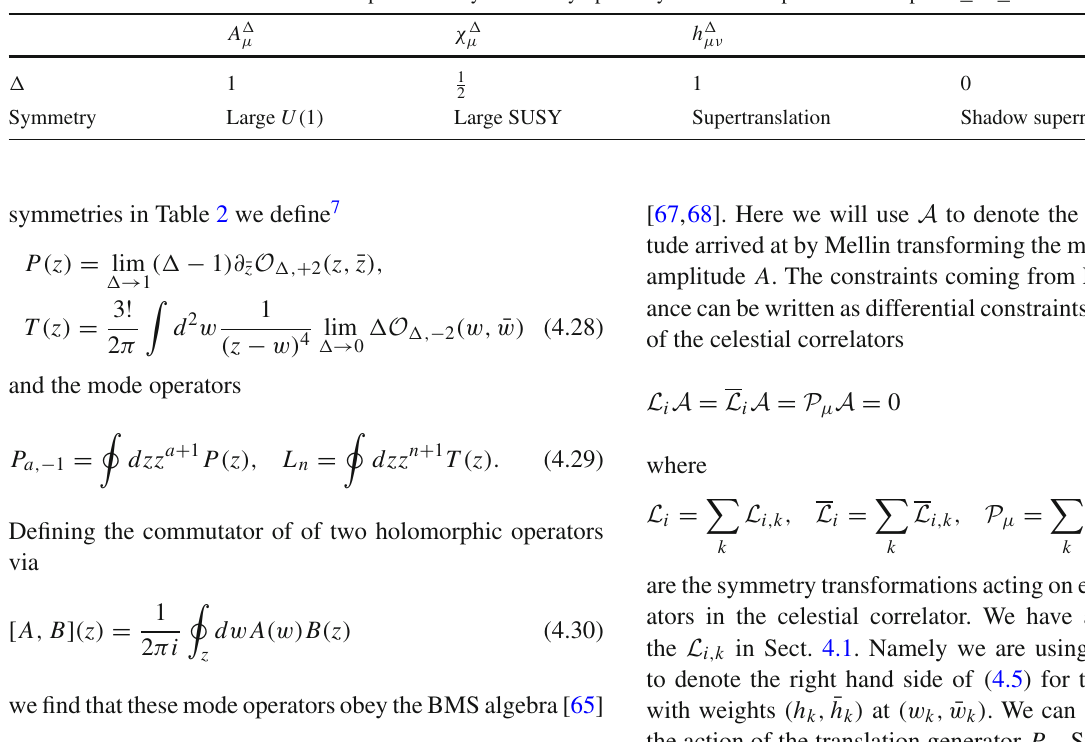
Table 2 Conformal Goldstone modes of spontaneously broken asymptotic symmetries for particles with spin 1 ≤ s ≤ 2